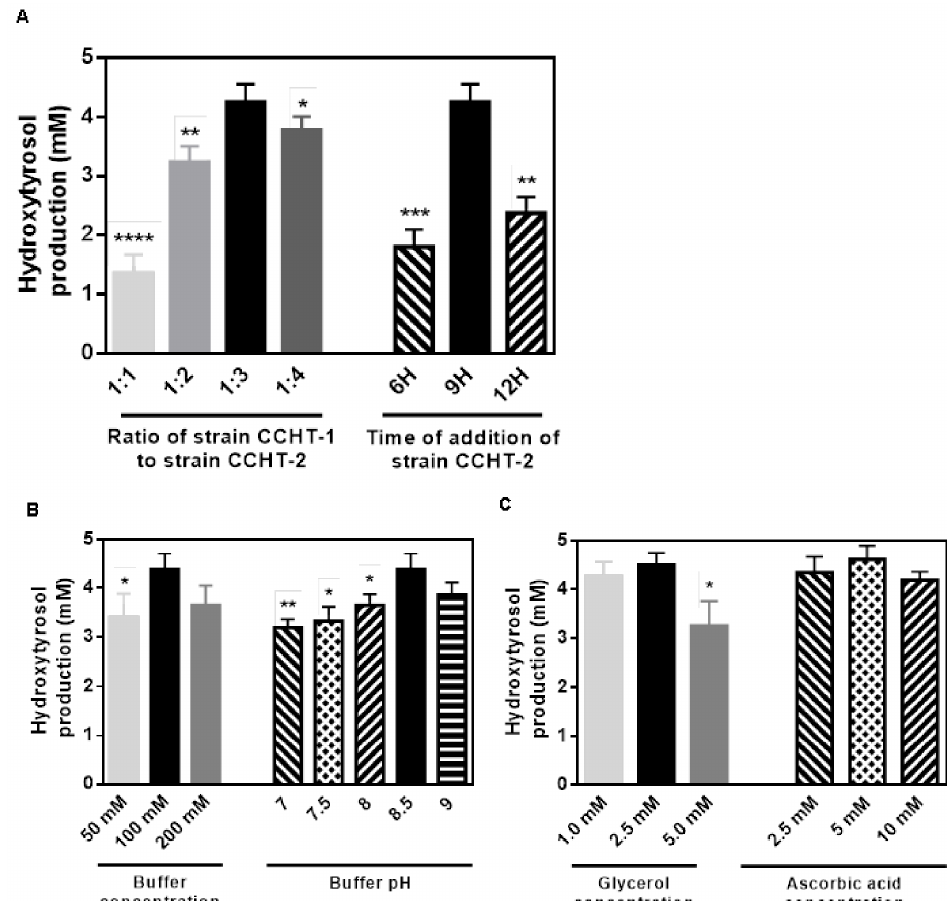
Figure 5. Optimization of the production of hydroxytyrosol from tyrosine. ( A ) Optimization of the ratio of two strains and the time of addition. ( B ) Optimization of buffer concentration and pH. ( C ) Optimization of the concentration of glycerol and ascorbic acid. 10 mM tyrosine was supplemented as substrate. Data are expressed as the mean ± SD ( n = 3). * p < 0.05, ** p < 0.01, *** p < 0.001, and **** p < 0.0001, compared to each control.